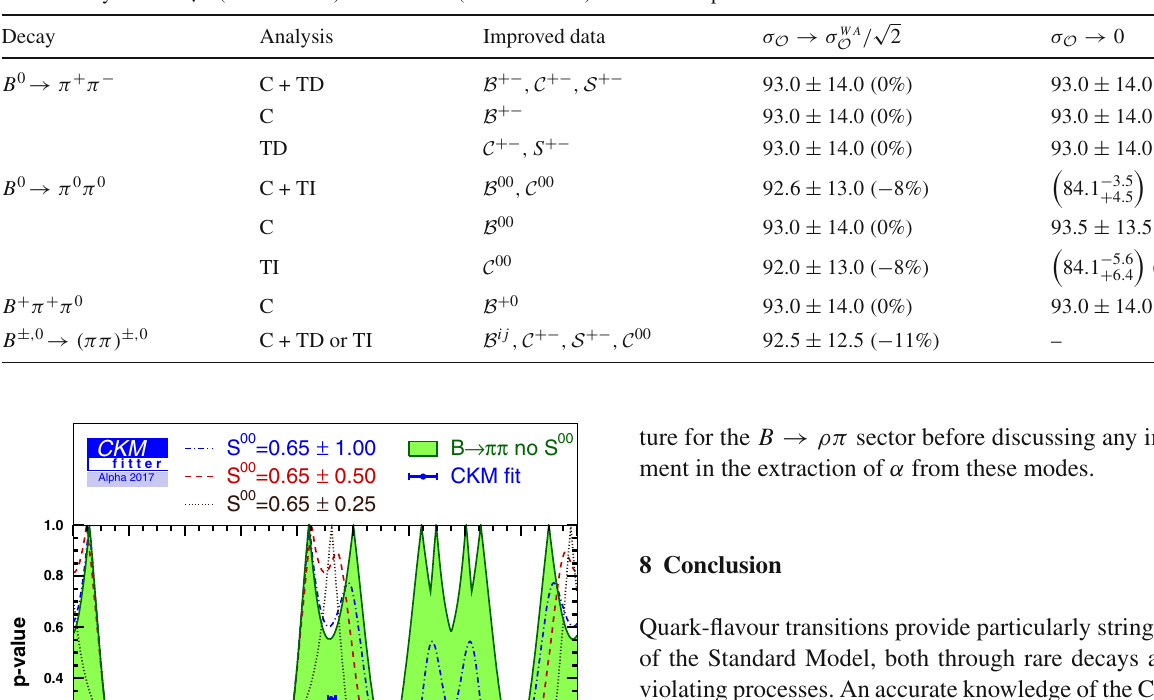
The relative gain in resolution with respect to the current measurement is indicated within brackets. Only the preferred solution for α close to 90 ◦ is reported